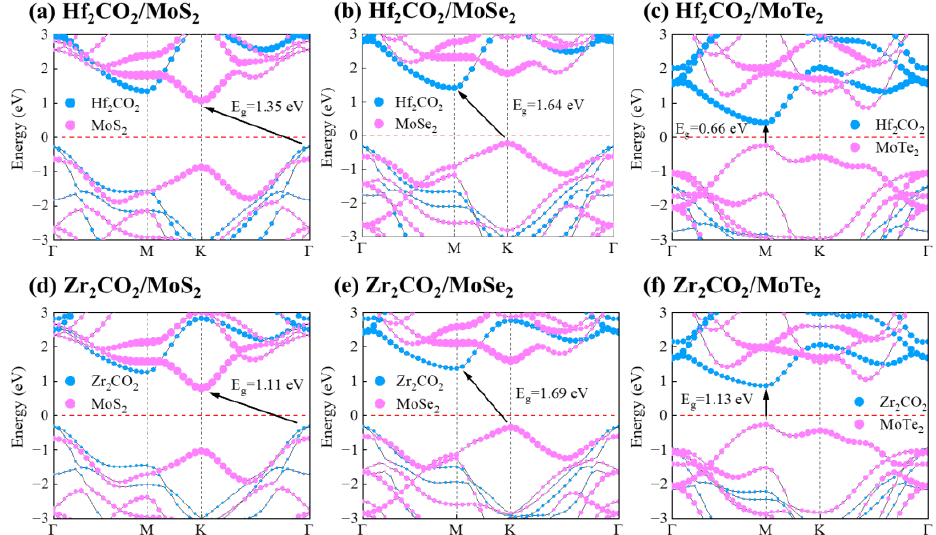
Figure 4. The projected band structures of ( a ) Hf 2 CO 2 /MoS 2 , ( b ) Hf 2 CO 2 /MoSe 2 , ( c ) Hf 2 CO 2 /MoTe 2 , ( d ) Zr 2 CO 2 /MoS 2 , ( e ) Zr 2 CO 2 /MoSe 2 and ( f ) Zr 2 CO 2 /MoTe 2 heterostructures using HSE06 functional. The Fermi energy level is set to zero.